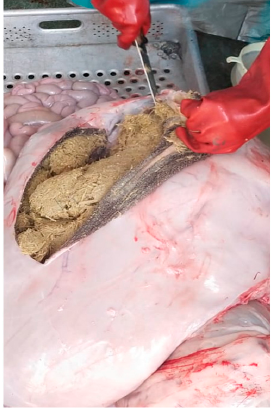
Figure 1. Sectioning of the rumen.